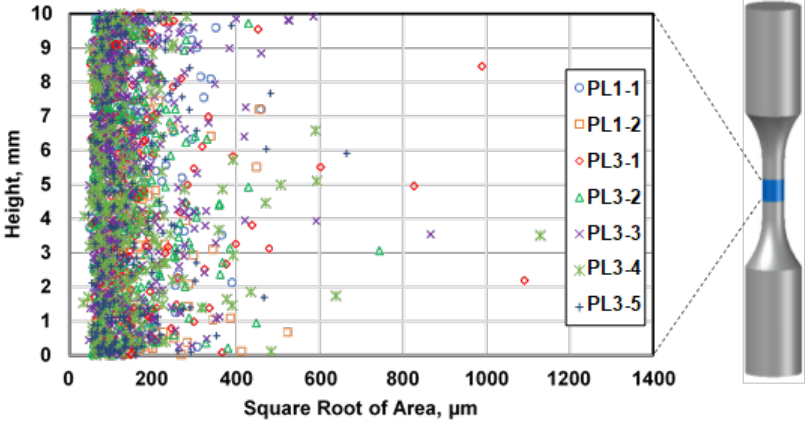
Figure 12. Distribution of defects along the height based on µCT data in large specimens. The symbols represent the defect data in different specimens at porosity levels 1 (PL1) and porosity level 3 (PL3).